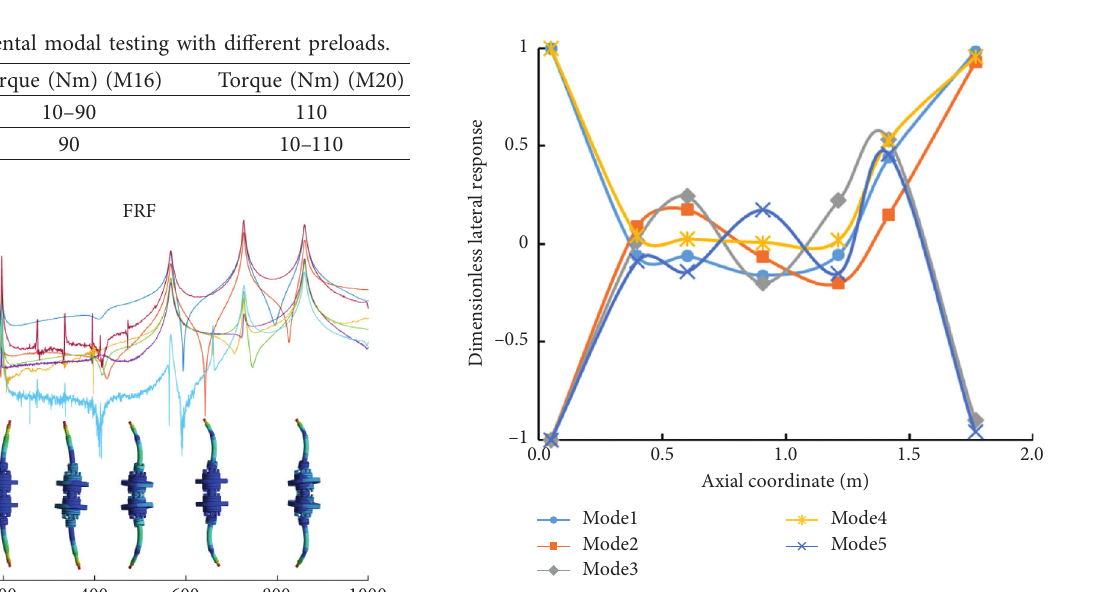
Figure 4: Experimental mode shape of the tie-bolt